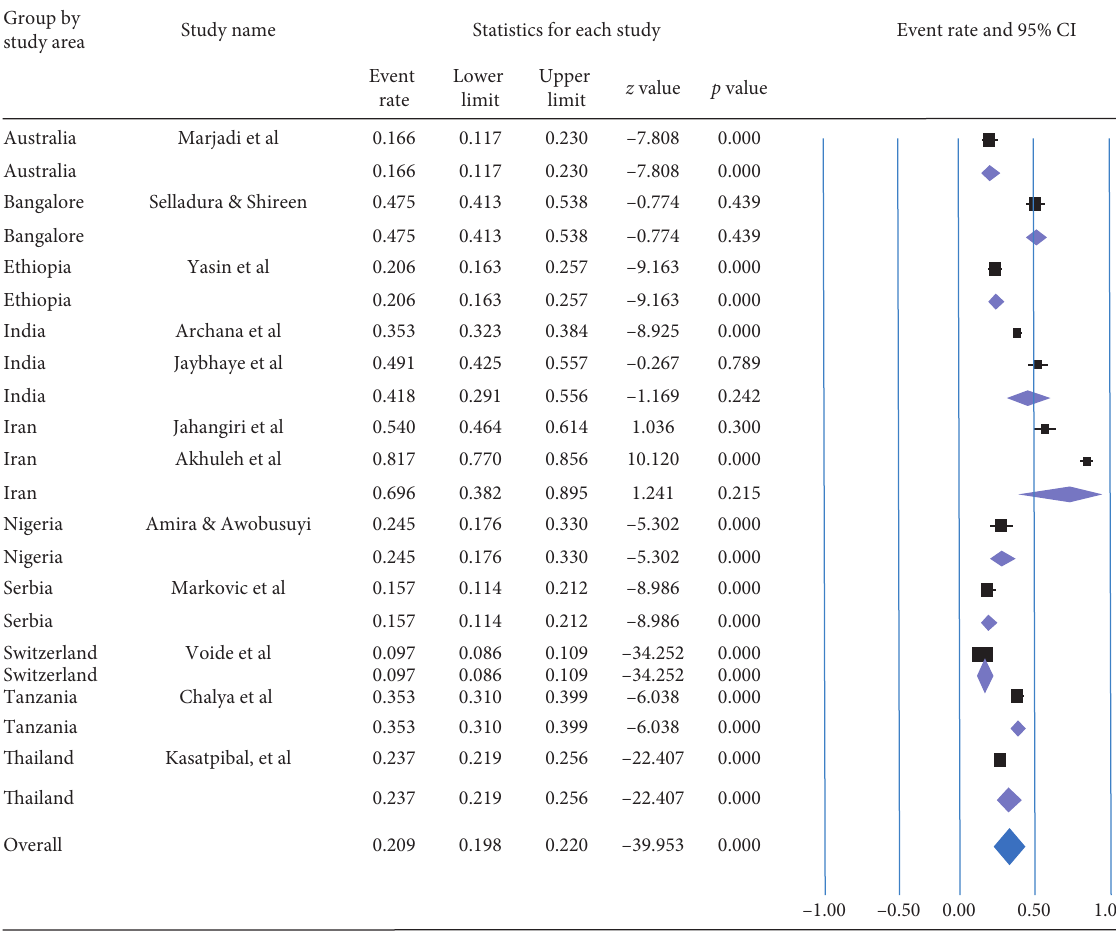
Figure 6: Forest plot shows the subgroup analysis of pooled prevalence of needle stick injury during the previous one year based on